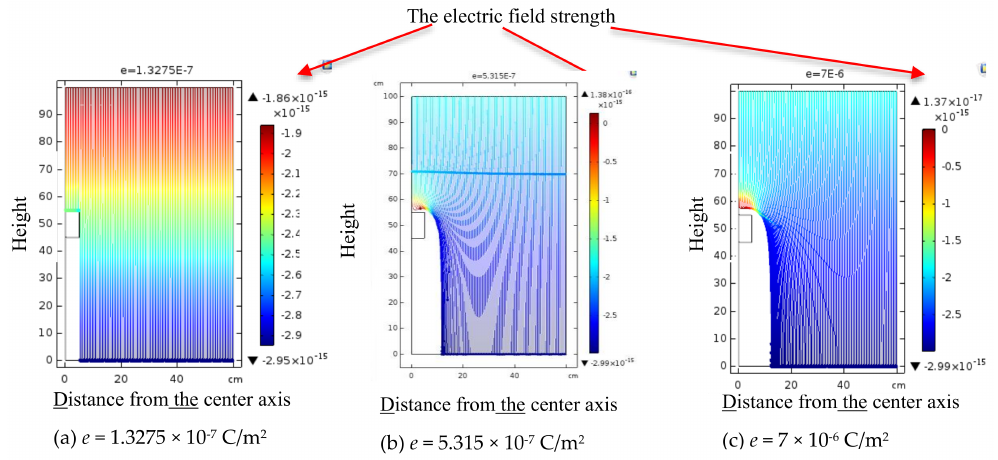
Figure 5. Particle trajectory of the initial state of top plate charged with different e